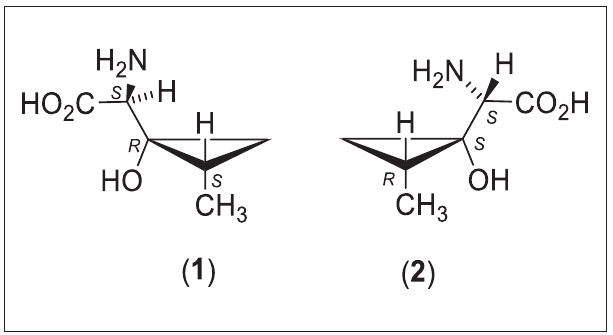
FIGURE 1: The chemical structures of diplonine (1 or